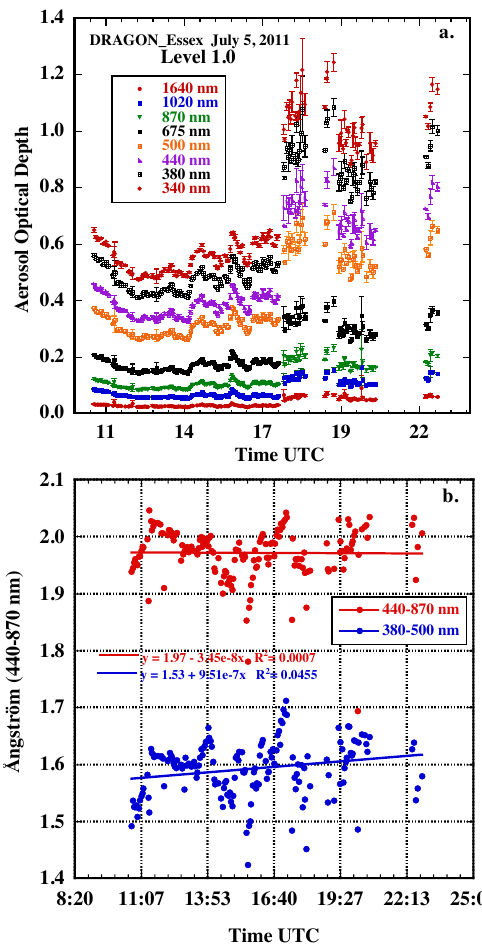
Figure 3. (a) The time series of spectral AOD measured at the DRAGON_Essex AERONET site on 5 July 2011, for data with no cloud screening (Level 1.0). The bars shown are ± half of the AOD triplet range (maximum–minimum AOD). (b) The time series of the Ångström exponent computed for two wavelength intervals from the same data as in (a) , including the linear fit to